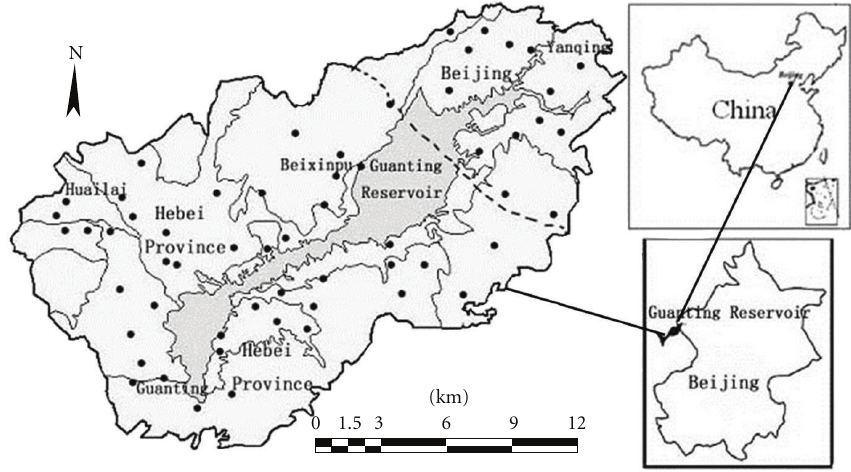
Figure 1: Locations of sampling sites around the Guanting